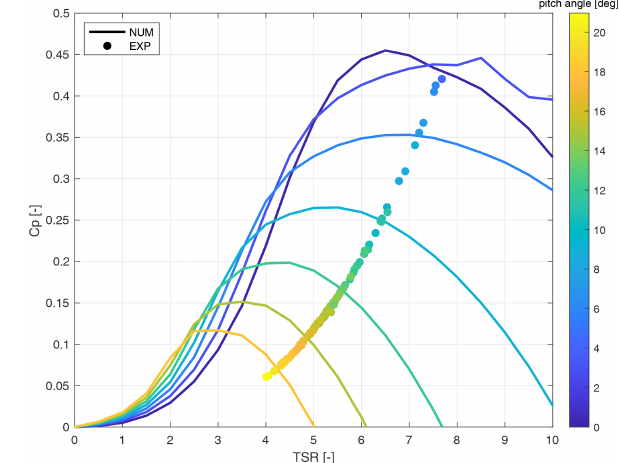
Figure 9. Power coefficient ( C P ) as a function of the TSR and pitch angle.